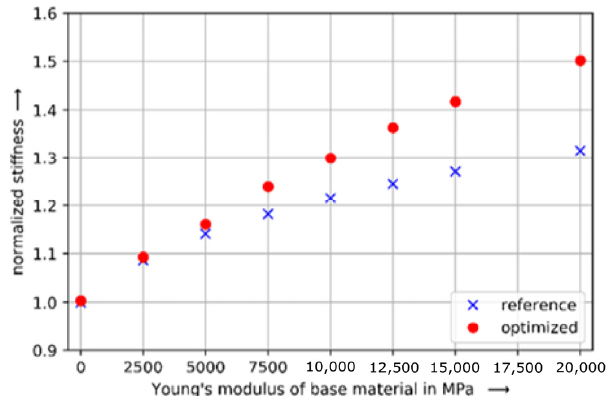
Figure 16. Stiffness for hybrid structures with different Young’s moduli of the base material. The reference is the optimization without consideration of the anisotropy of the reinforcing material and the stiffness of the base material. It can be shown that with increasing Young’s modulus of the base material the new procedure leads to stiffer results.